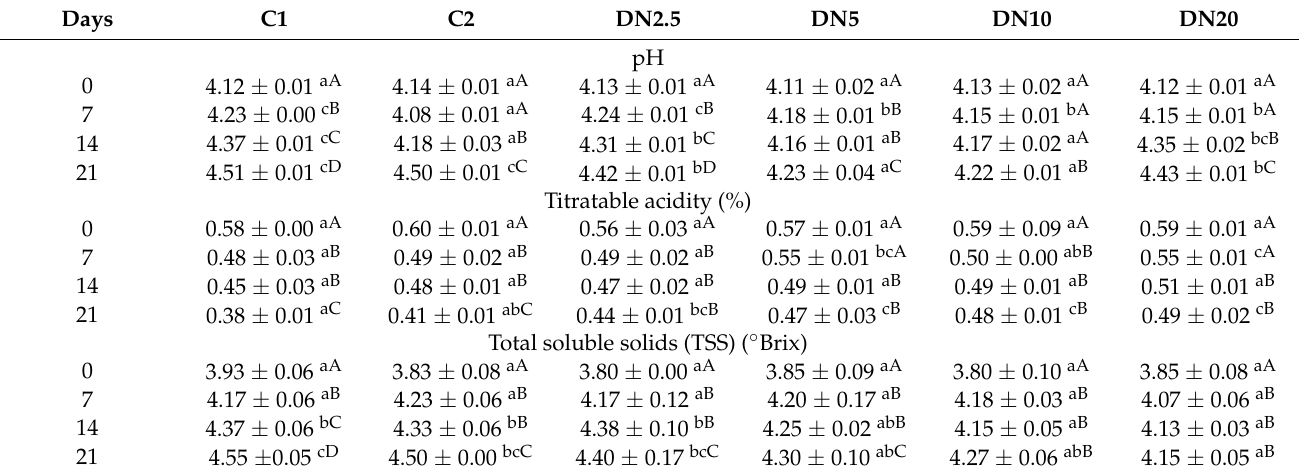
Table 2. Physicochemical parameters in tomato fruits coated with nanoemulsion during